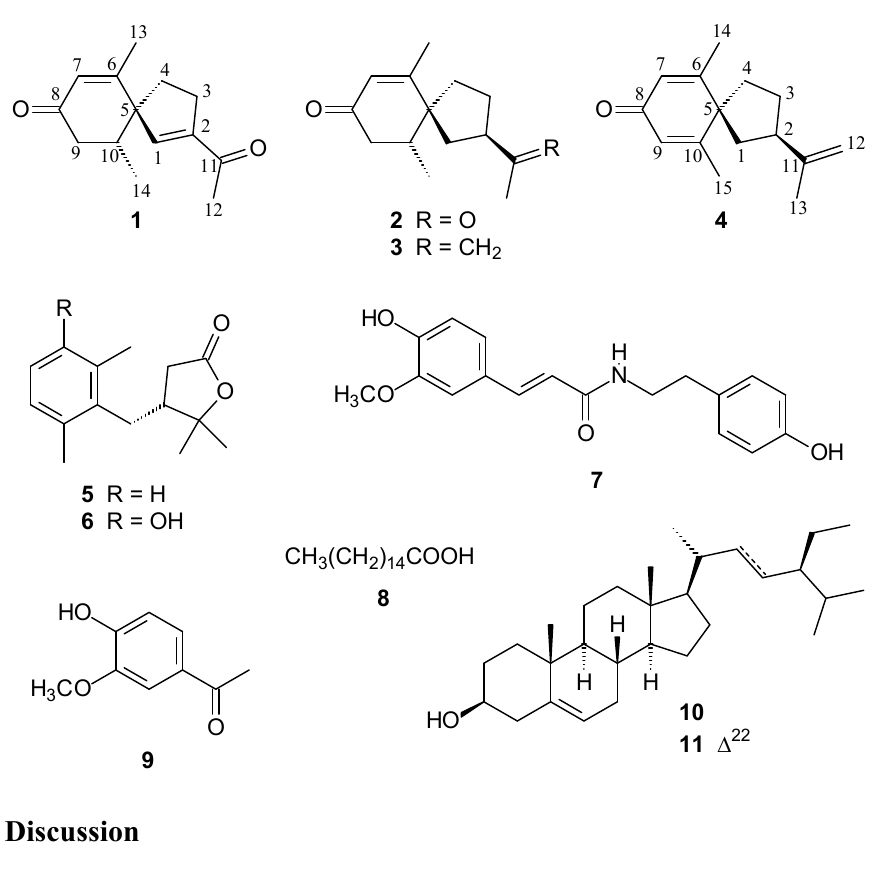
Figure 1. The chemical structures of compounds 1 – 11